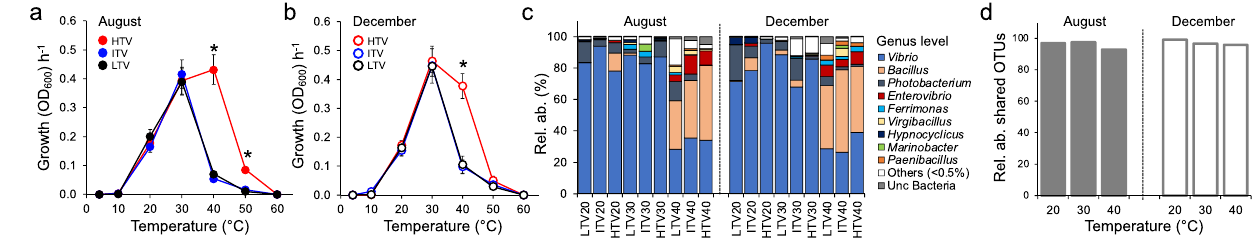
c Taxonomic diversity, at the genus level, of the enriched heterotrophic bacteria presentattheendofincubationatdifferenttemperatures(20°C,30°C,and40°C) in August and December; values are expressed as the relative abundance of each genus measured at the end of the incubation (when samples were collected). d Relative abundance of OTUs shared across the enriched heterotrophic bacterial community fraction from HTV, ITV and LTV, grown at 20°C, 30°C, and 40°C; values are expressed as